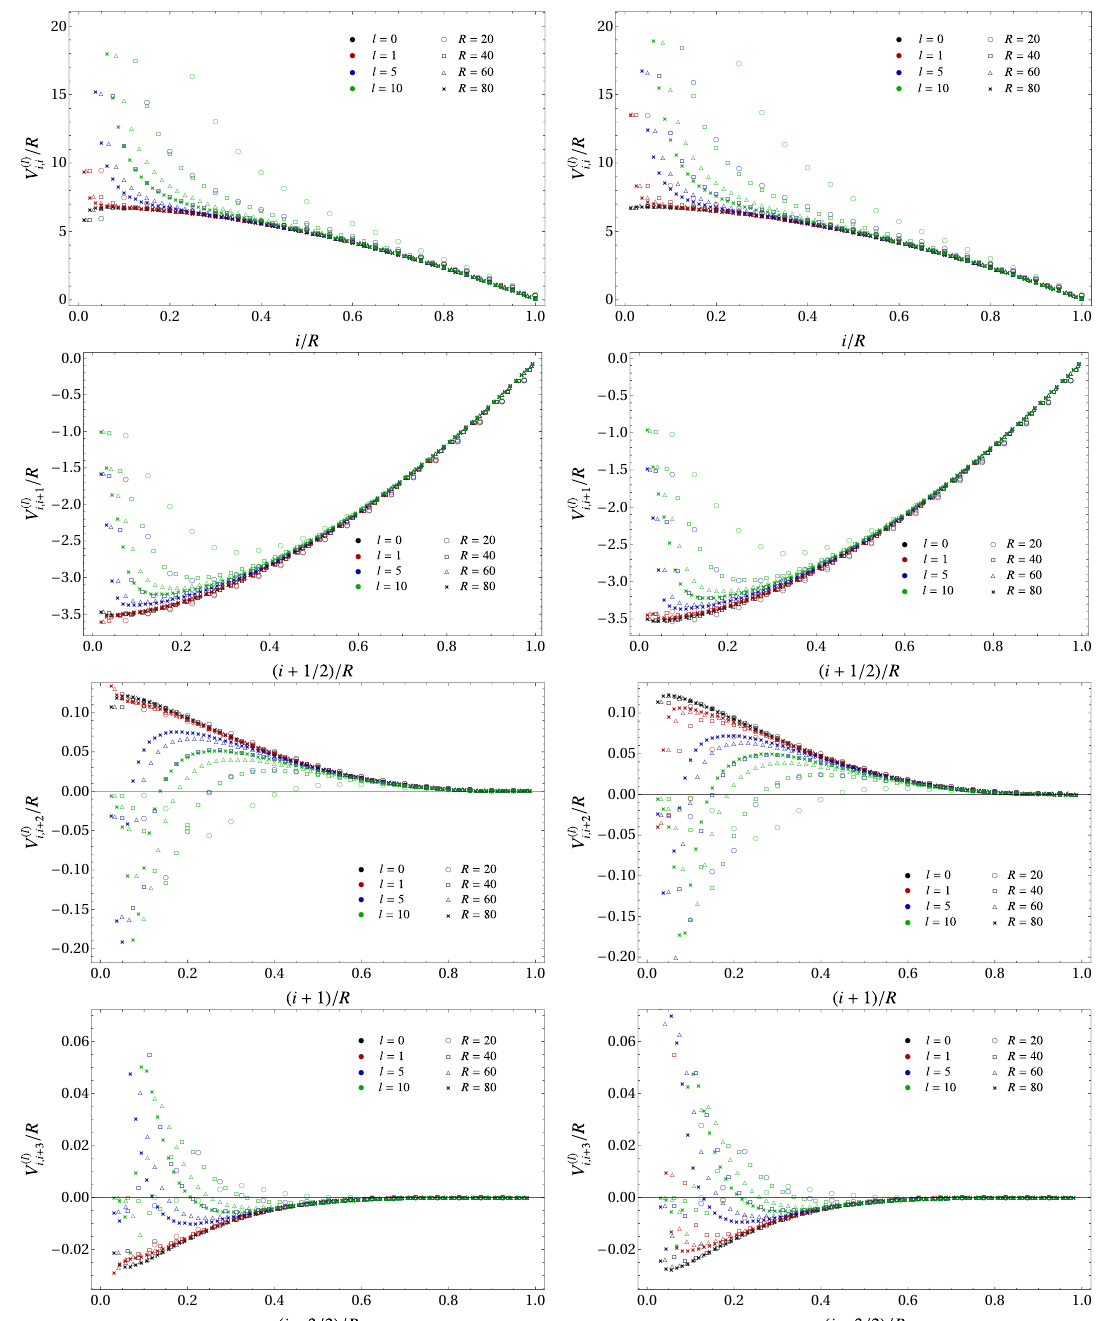
Figure 2. Short-range couplings in the matrix V ( l ) /R (see (3.2) and (3.5)) when ω = 0 and either d = 2 (left panels) or d = 3 (right panels), for some small l ’s and different sizes R